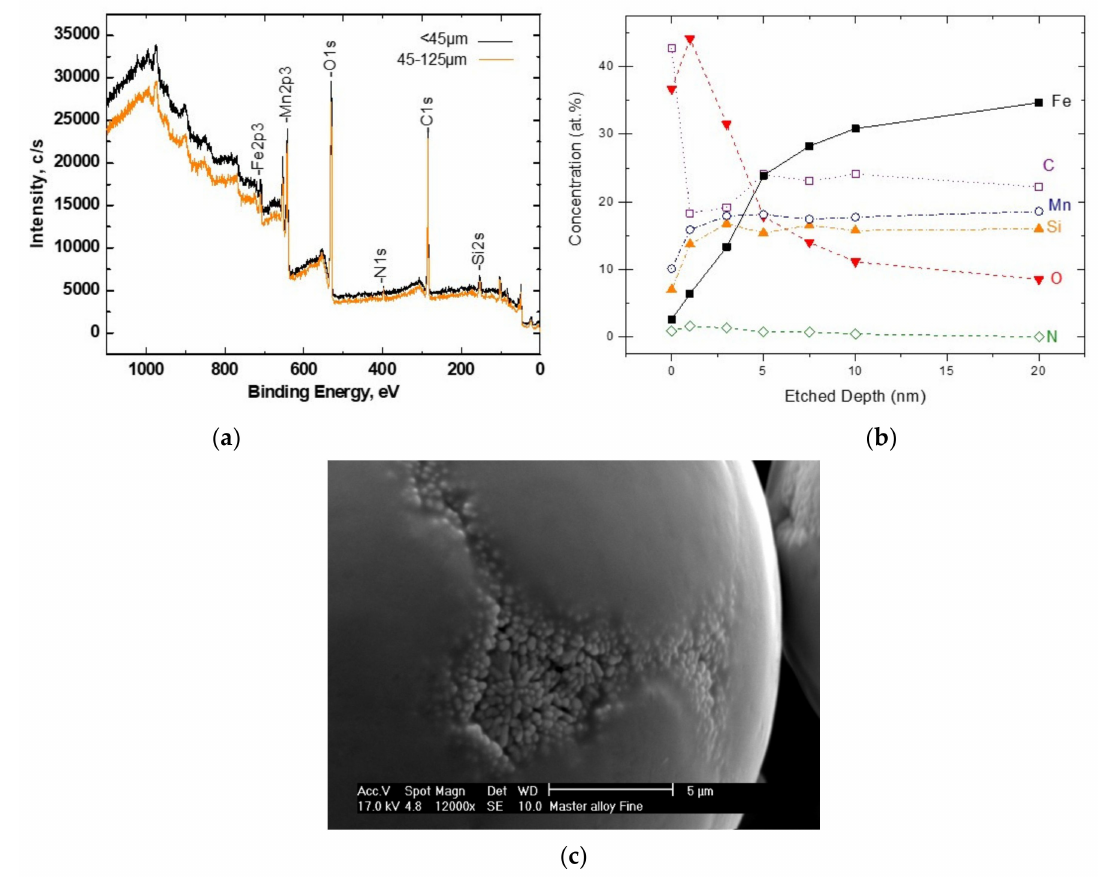
Figure 10. Surface Analyses on master alloy powder particles ( a ) The X-ray Photoelectron Spectroscopy (XPS) survey scan on the master alloy powder surface for two fractions of powder: <45 µ m and 45–125 µ m; ( b ) Composition profile of the master alloy powder; ( c ) Scanning electron microscopy (SEM) image of the master alloy powder. Detailed image of the more stable particulate oxides